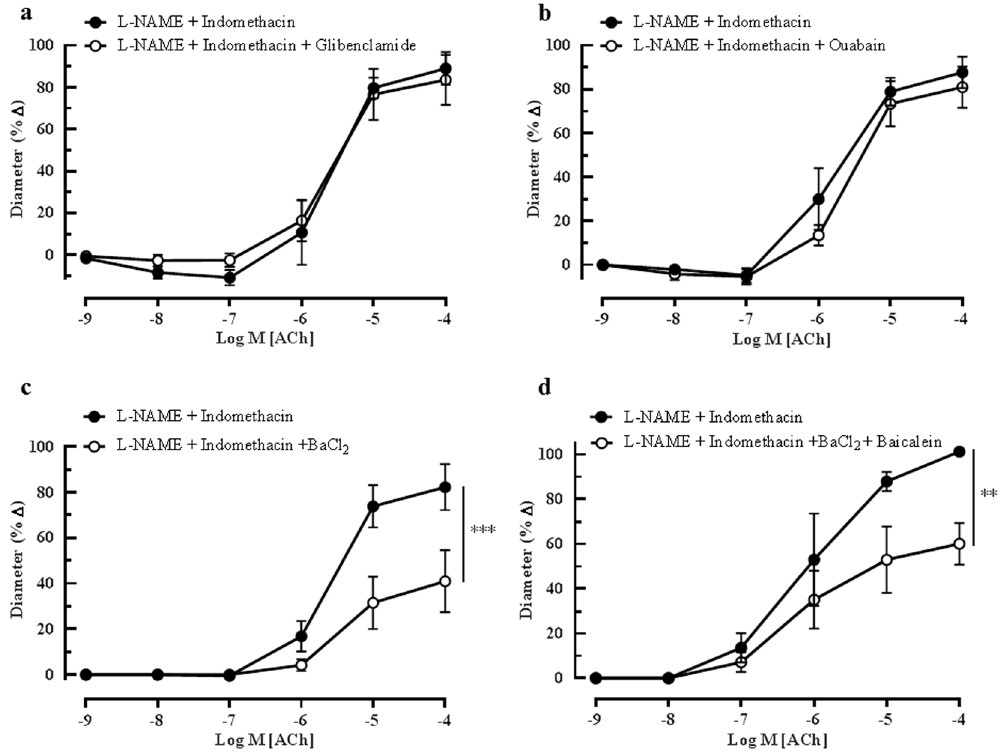
Figure 8. Cholinergic vasodilation of the mouse ophthalmic artery in the presence of potassium ion channels and Na + /K + -ATPase blockers. Incubation of the vessels with ( a ) glibenclamide and ( b ) ouabain elicited no significant inhibitory effects on ACh-mediated vasodilation. However, the inhibition of the ( c ) Kir channels with BaCl 2 and, ( d ) combination blockade of Kir channels and LOX pathway with BaCl 2 and baicalein caused a significant inhibition of dilation. Values are expressed as mean ± s.e.m (n = 4–6 per group; *** P < 0.001, L-NAME and indomethacin vs L-NAME and indomethacin and BaCl 2 , ** P < 0.01, L-NAME and indomethacin vs L-NAME and indomethacin and BaCl 2 and